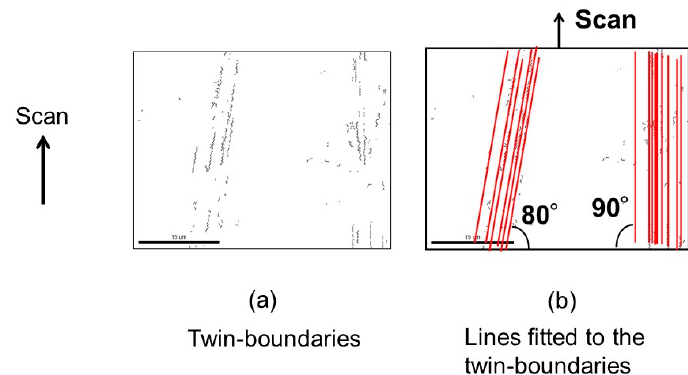
Figure 14. EBSD maps of ( a ) twin boundaries, and ( b ) the lines fitted to the twin boundaries. The same area of the sample shown in Figure 13 was investigated. The SiO 2 cap thickness was 183 nm, and the power was 2.6 W. The scan velocity was 15 mm/s. After Sasaki et al. [53].